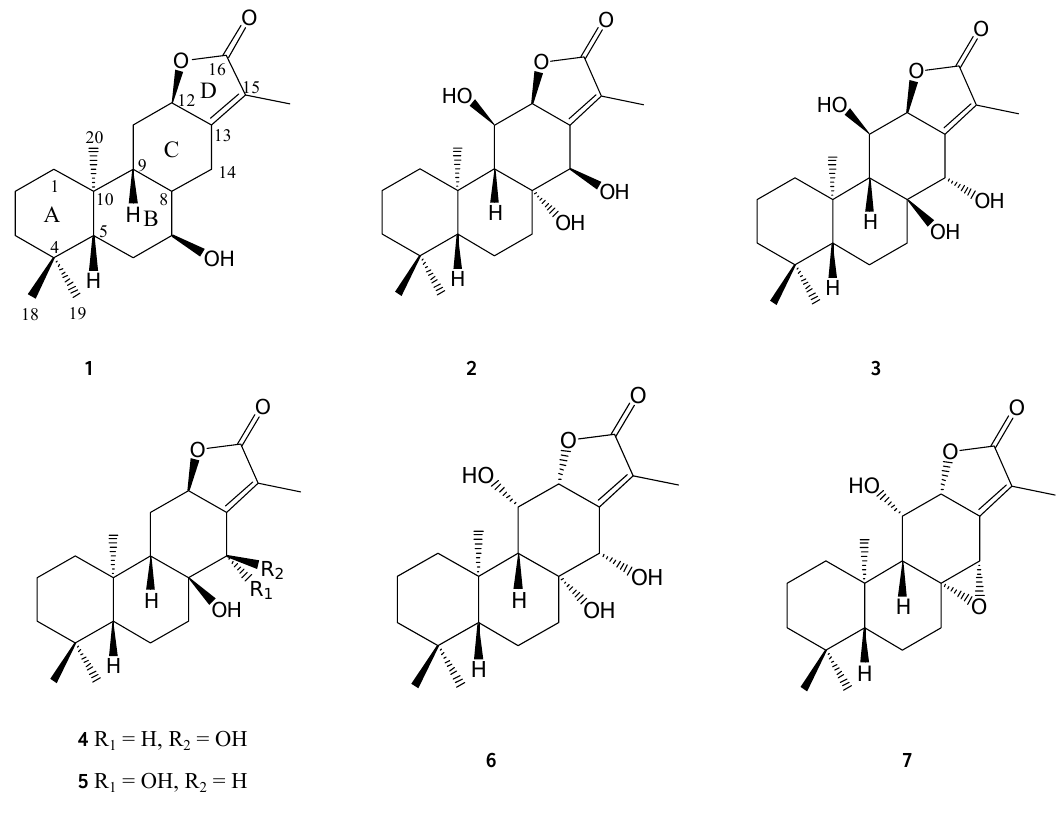
Figure 1. Abietane diterpenoids isolated from Euphorbia